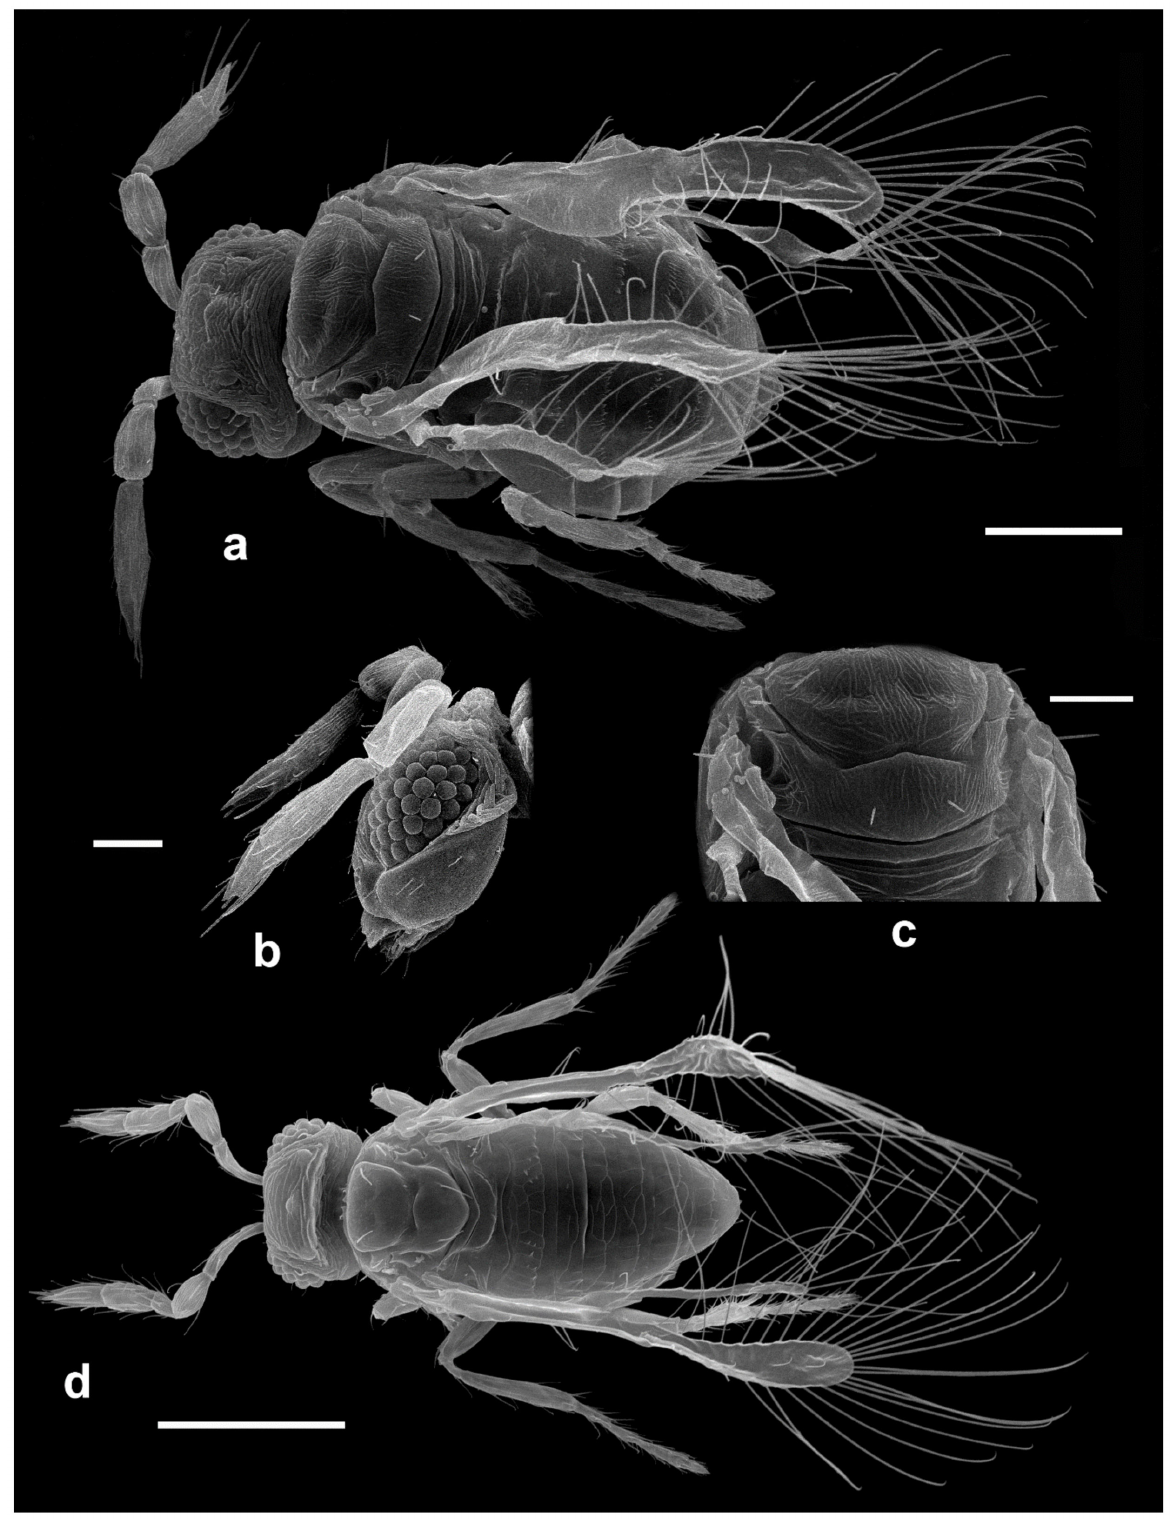
Figure 19. SEM micrographs of Megaphragma species (non-types): ( a ) M. caribea , male habitus; ( b ) M. caribea , male head and antennae; ( c ) M. caribea , male mesoscutum; ( d ) M. polilovi , female dorsal habitus. Scale bars 50 µ m for a, 20 µ m for b and c, and 100 µ m for